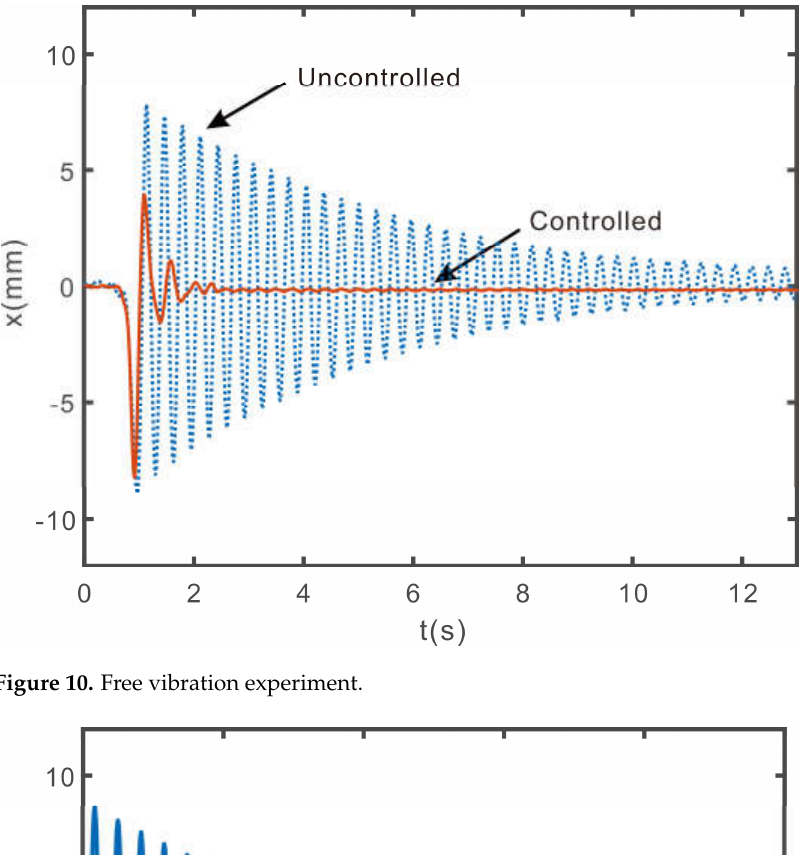
Figure 9. Simulink block diagram for the PIPO controller.